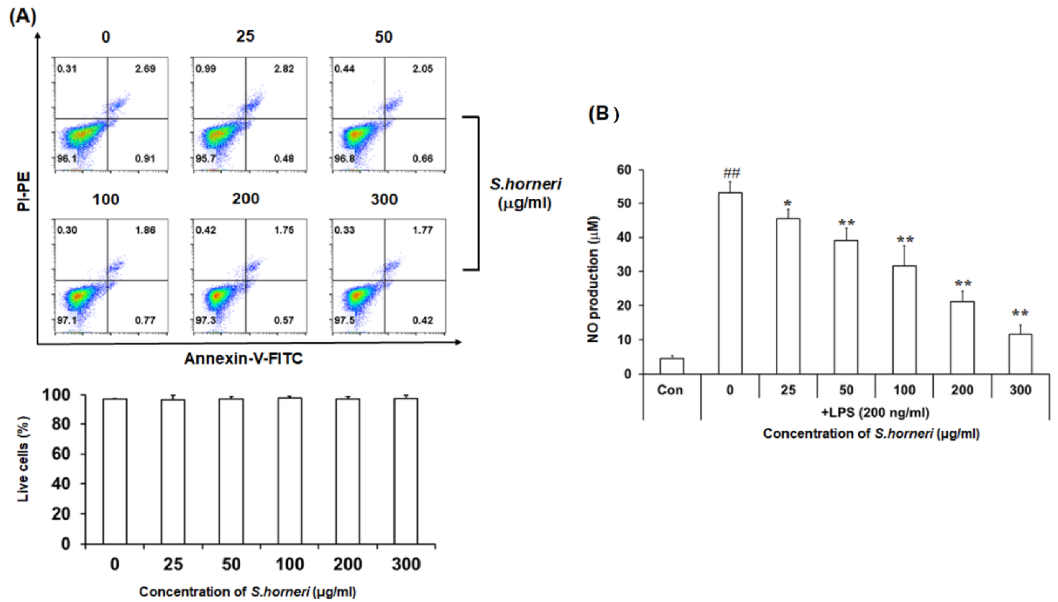
Figure 1. Anti-neuroinflammatory effect of S. horneri extract on NO production in LPS-stimulated BV-2 microglial cells. Microglial cell viability was determined by Annexin-V/PI assay after S. horneri extract treatment with BV-2 microglial cells ( A ). After S. horneri extract treatment of BV-2 microglial cells stimulated with LPS (200 ng/mL), NO production ability was determined by Griess assay ( B ). The result is representative of three repeated independent experiments. Experimental results were indicated as mean (±SE). * p <0.005, ** p < 0.001, significantly different from LPS-treated group; ## p < 0.001, significantly different from LPS-untreated group.